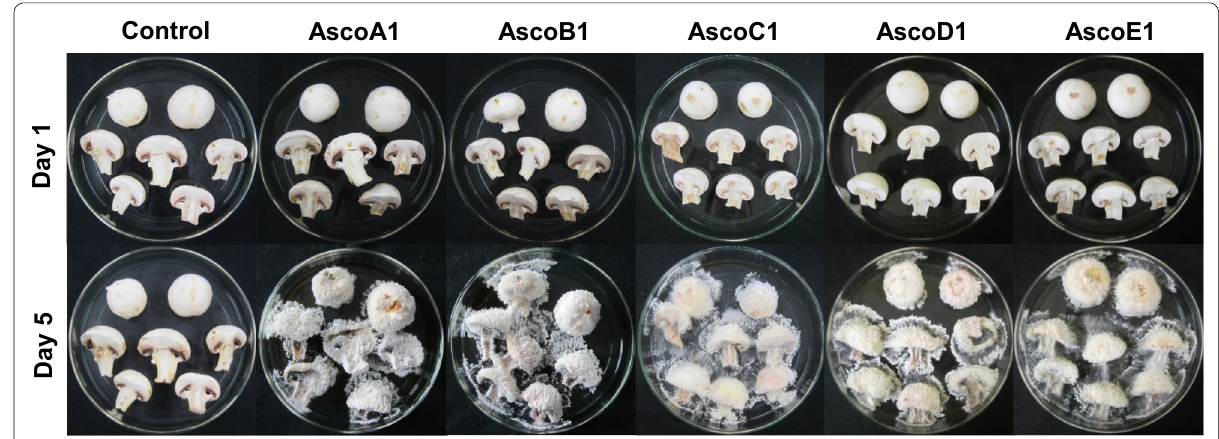
Fig. 6 Infection test with commercial A. bisporus fruiting bodies. Top row: day of inoculation, bottom: mushrooms after 5 days of cultivation at